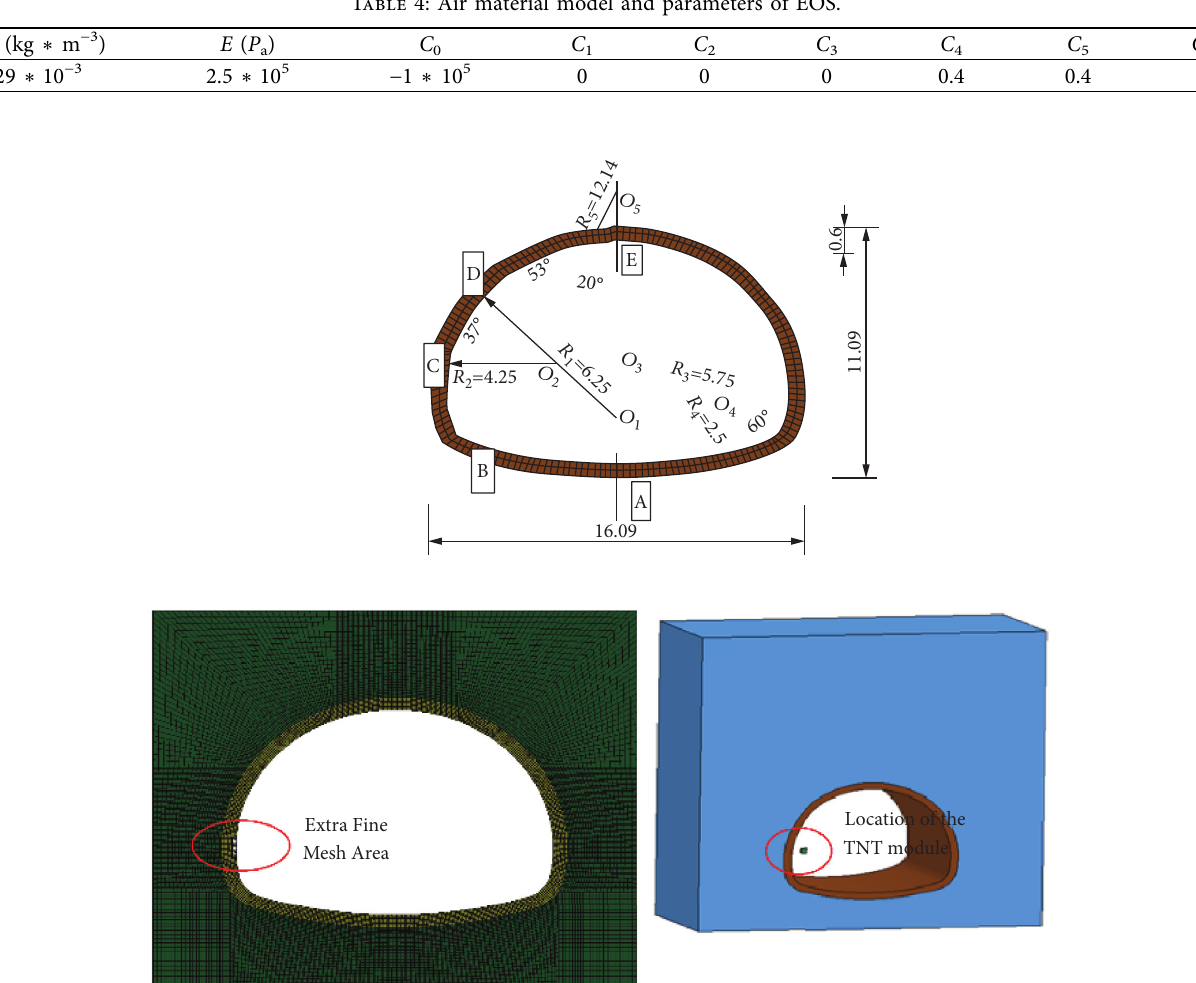
Figure 4: The geometry of the tunnel cross section and the mesh diagram.